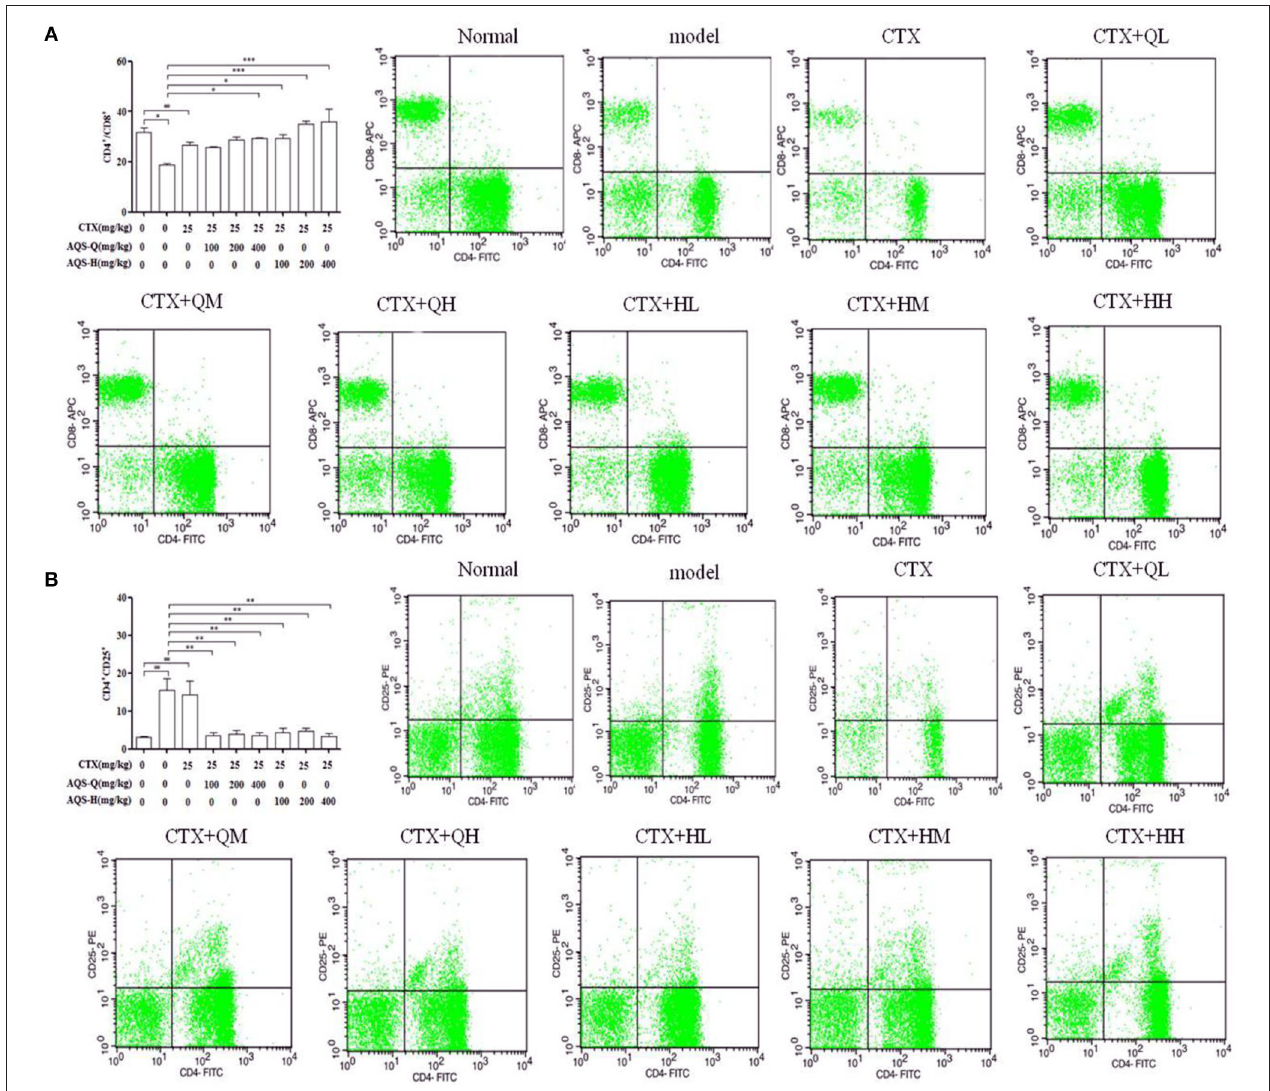
FIGURE 6 | Flow scatter plot of T lymphocyte subsets ( n = 8). Percentage of T lymphocyte subsets and (A) CD4 + /CD8 + , (B) CD4 + CD25 + T lymphocyte ratio. Values are presented as mean ± SD. vs. normal group, ## P < 0.01, ### P < 0.001; vs. model group, * P < 0.05, *** P <